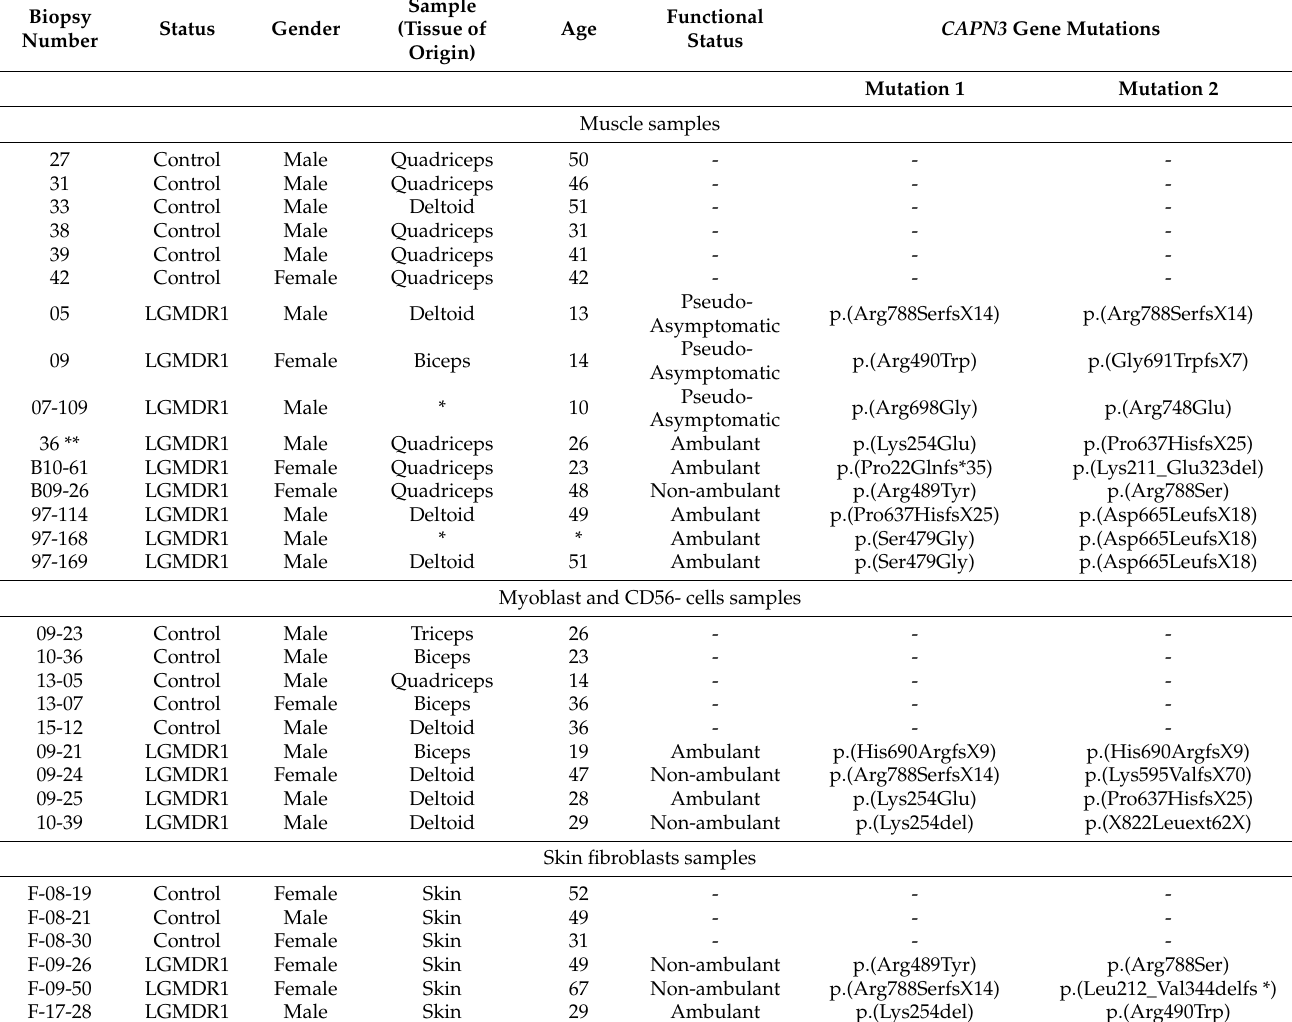
Table 1. Muscle and myoblast samples from healthy controls and LGMDR1